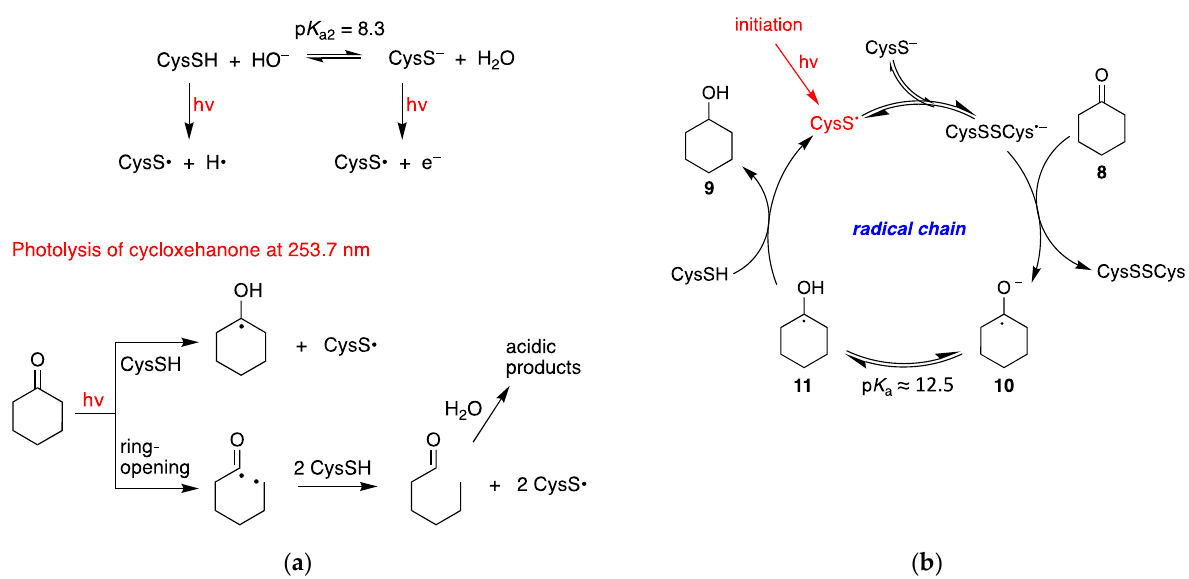
Figure 3. Proposed reaction mechanism for the reduction of cyclohexanone to cyclohexanol: ( a ) Possible initiation steps; ( b ) The radical chain reaction.